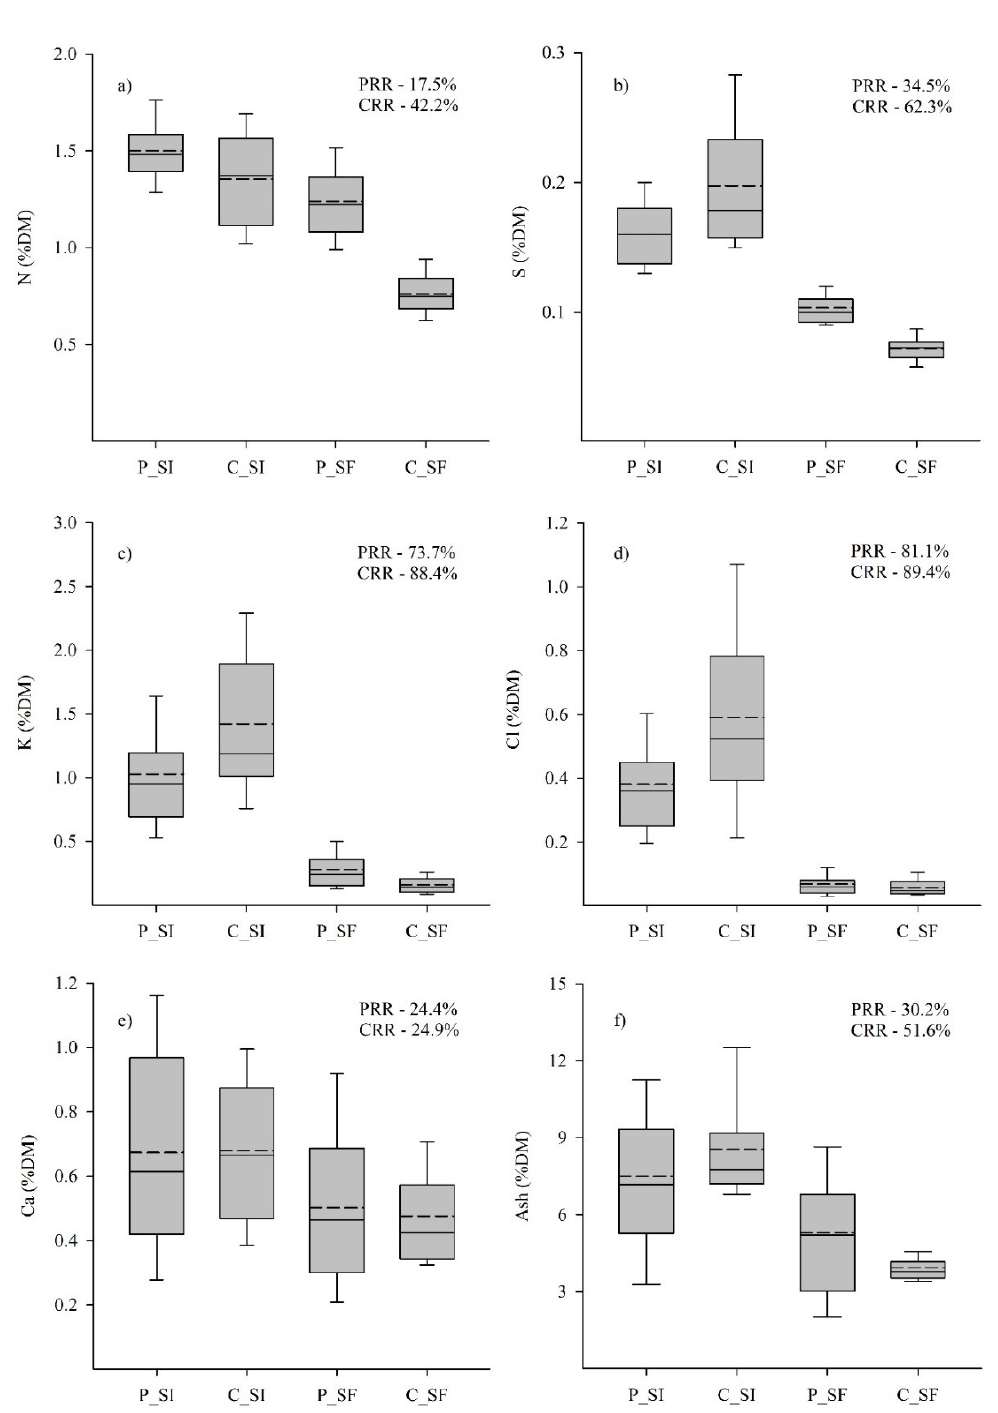
Figure 4. Concentration of ( a ) N, ( b ) S, ( c ) K, ( d ) Cl, ( e ) Ca, and ( f ) Ash in the silage (P_SI) and solid fuel (P_SF) on the prototype- scale and commercial-scale (C_SI, C_SF) plant. The corresponding average reduction rate for elements during dewatering for the prototype (PRR) and commercial scale (CRR) is shown in the top right corner of each plot. The dashed line in the box plots denotes the arithmetic mean and the solid line represents the median. For prototype (P) number of observations were n = 108 and for commercial scale (C) number of observations were n = 36. Boxes represent the 25th and 75th percentile and whiskers indicate the 10th and 90th percentile values excluding outliers. Ash softening temperature of solid fuel in CS was 1163 °C compared to 1050 °C in PT, which cannot be fully attributed to scaling effects, as AST in CS silage was also higher. The improvement in AST between silage and solid fuel for both CS and PT were similar (10%) and for AFT the trend was similar, with 1335 °C for CS and 1290 °C for PT, but the rate of increase in both cases was only 3%.